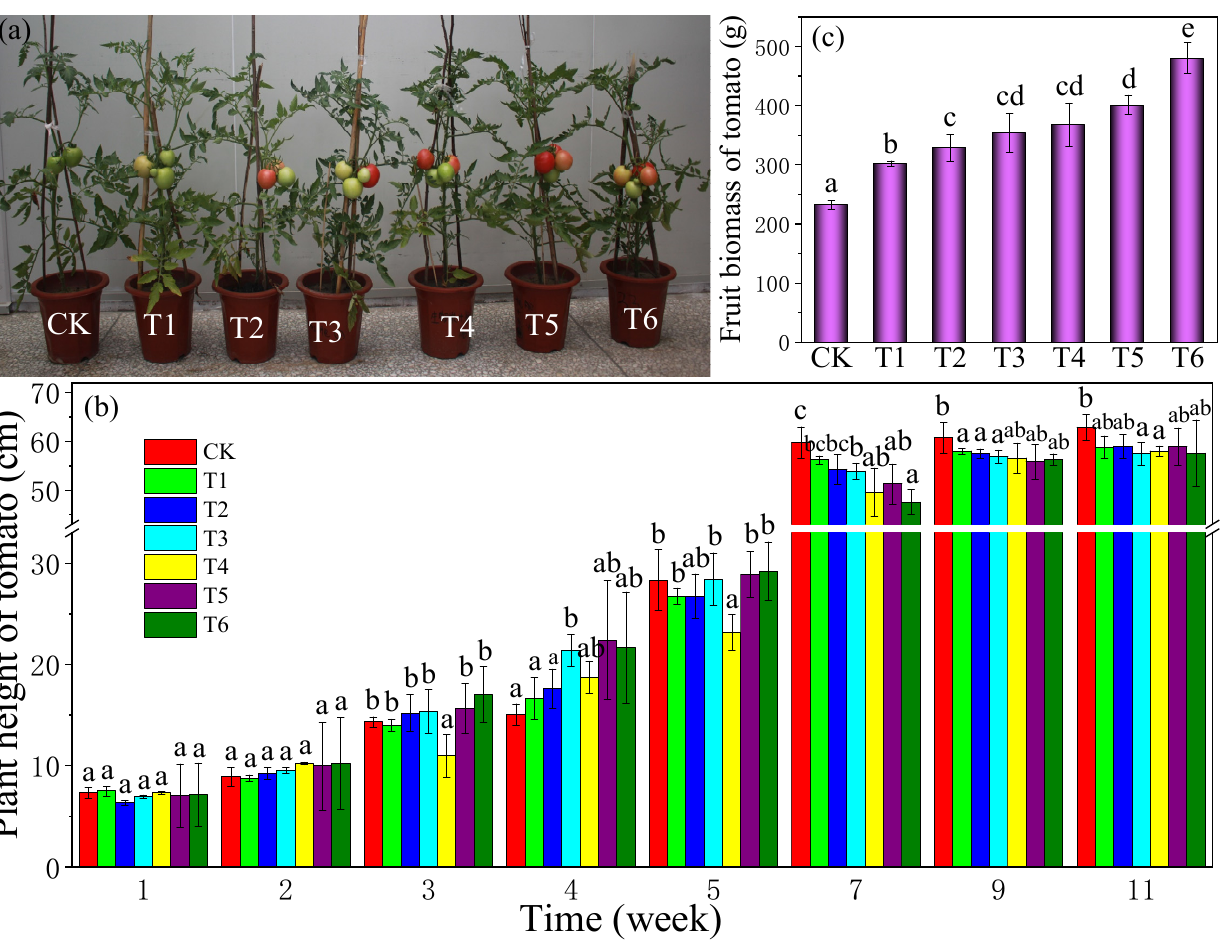
Figure 2. Effect of different treatments on growth status ( a ), plant height ( b ), and fruit biomass ( c ) of tomato. Data with different letters are significantly different ( p < 0.05).